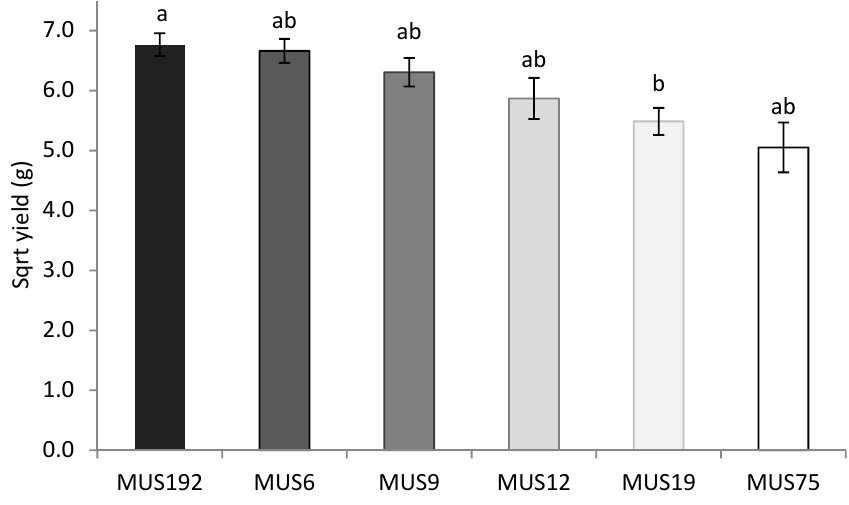
Figure 1. Effect of strain on the fruiting body yield of G. lucidum estimated in Equation (2). Significant differences ( p < 0.05) between the estimated square root yields are represented with different letters (a and b).